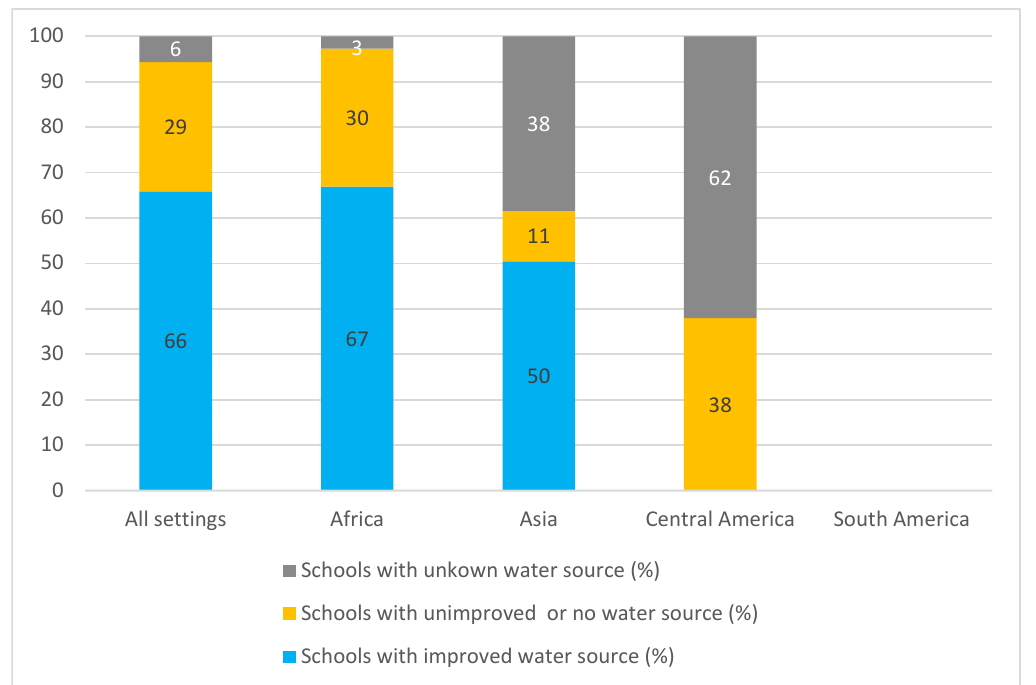
Figure 3. Percentage of schools with improved, unimproved/no drinking water source and unknown source based on the review of the literature (n = 65 publications). Number of schools in each setting: Africa n = 12,997; Asia n = 832; Central America = 456; South America n = 0; All settings n = 16,963. The total number of schools assessed in all settings (16,963) is lower than the sum of schools per continent (14,285) as some of the studies did not identify the schools per